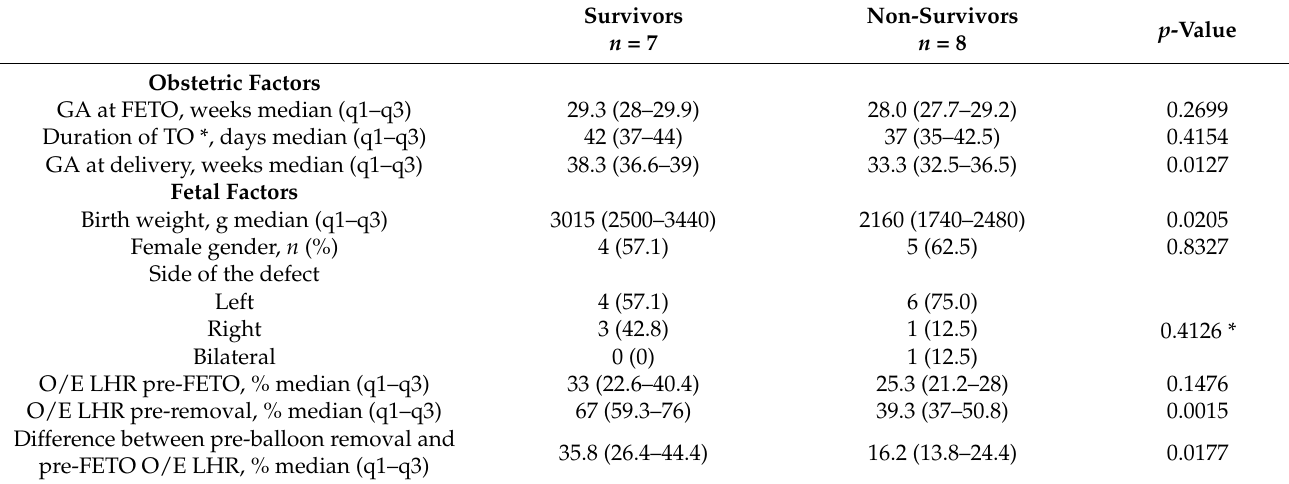
Table 1. Obstetric and fetal characteristics in fetuses that survived compared to those who died.